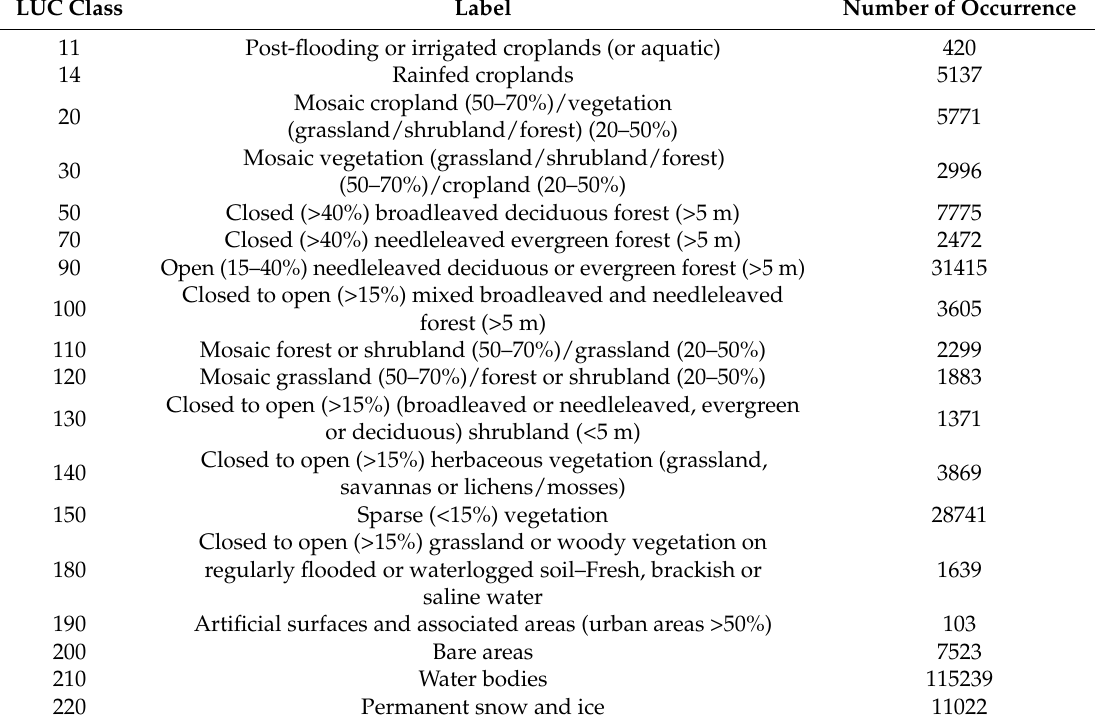
Table 1. GlobCover2009 classes found to be most common within one surface albedo (SAL) resolution unit in the study area and the number of occurrences of each class as the most common land-use class in one resolution unit of melt season